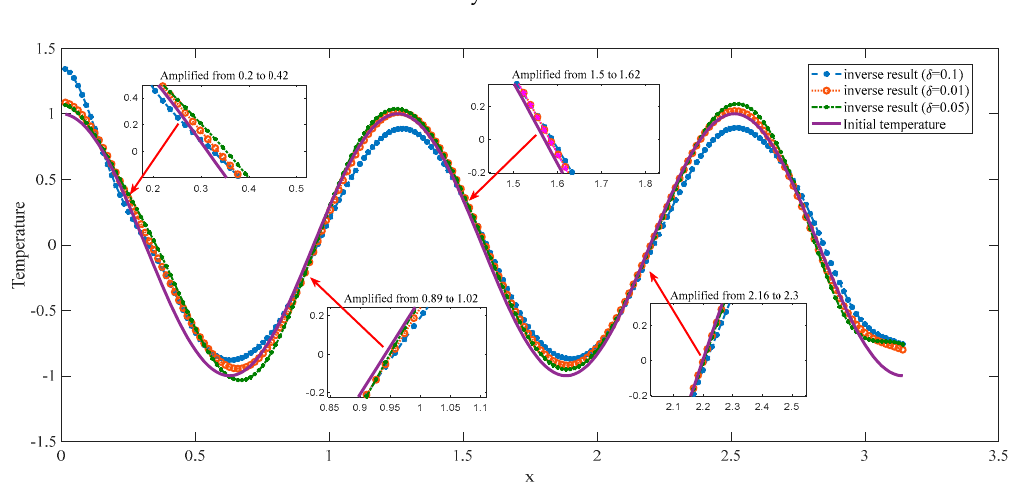
Figure 1. Recovery of ( 0) u x, from the measuring data ) u x,T